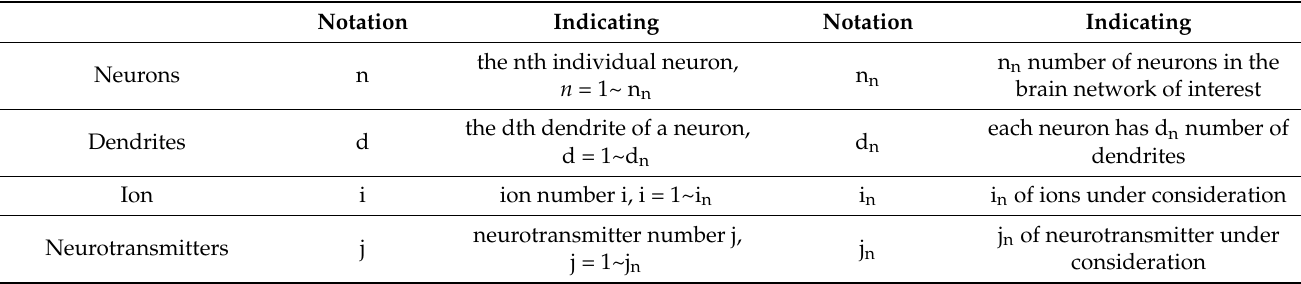
Table 1. Notations used in brain